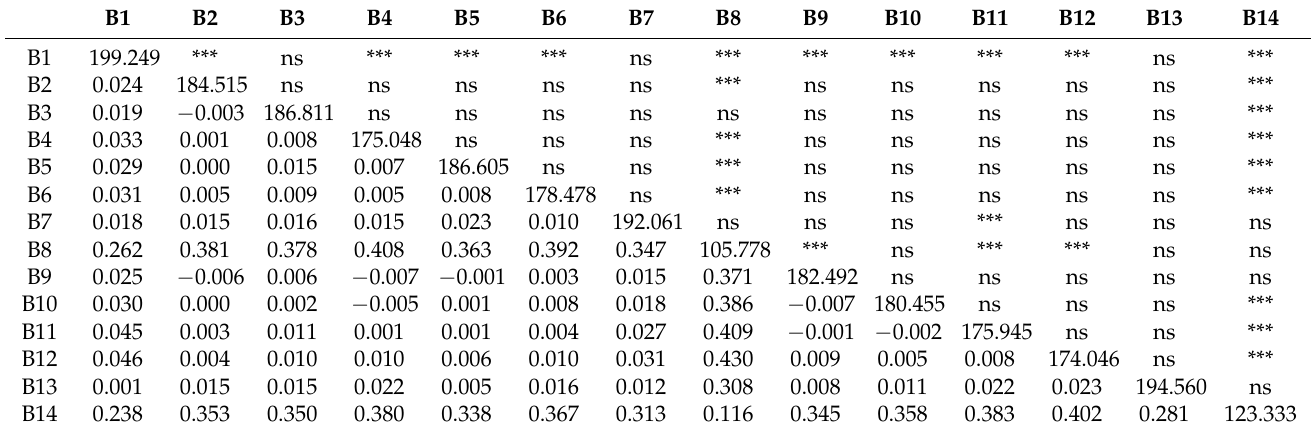
Table 3. Population pairwise F ST calculated considering sampling stations in the Biferno river, calculated in Arlequin. On diagonal: average number of pairwise difference within population. Above the diagonal: the p -value significance after Bonferroni correction. Sample locations and codes are detailed in Table S1.